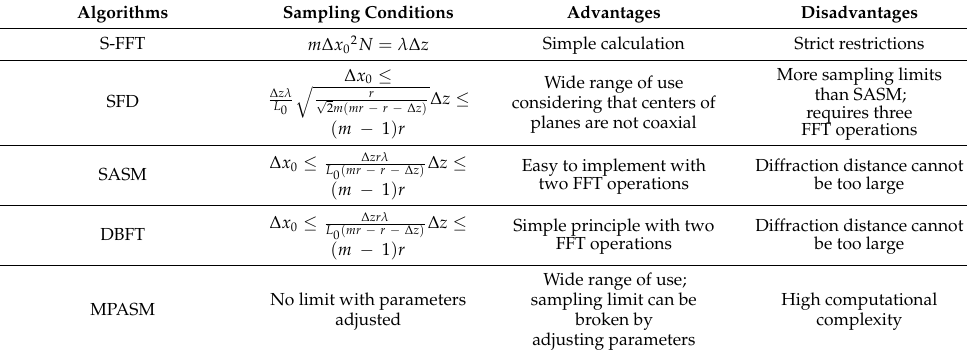
Table 3. Comparison and Summary of Diffraction